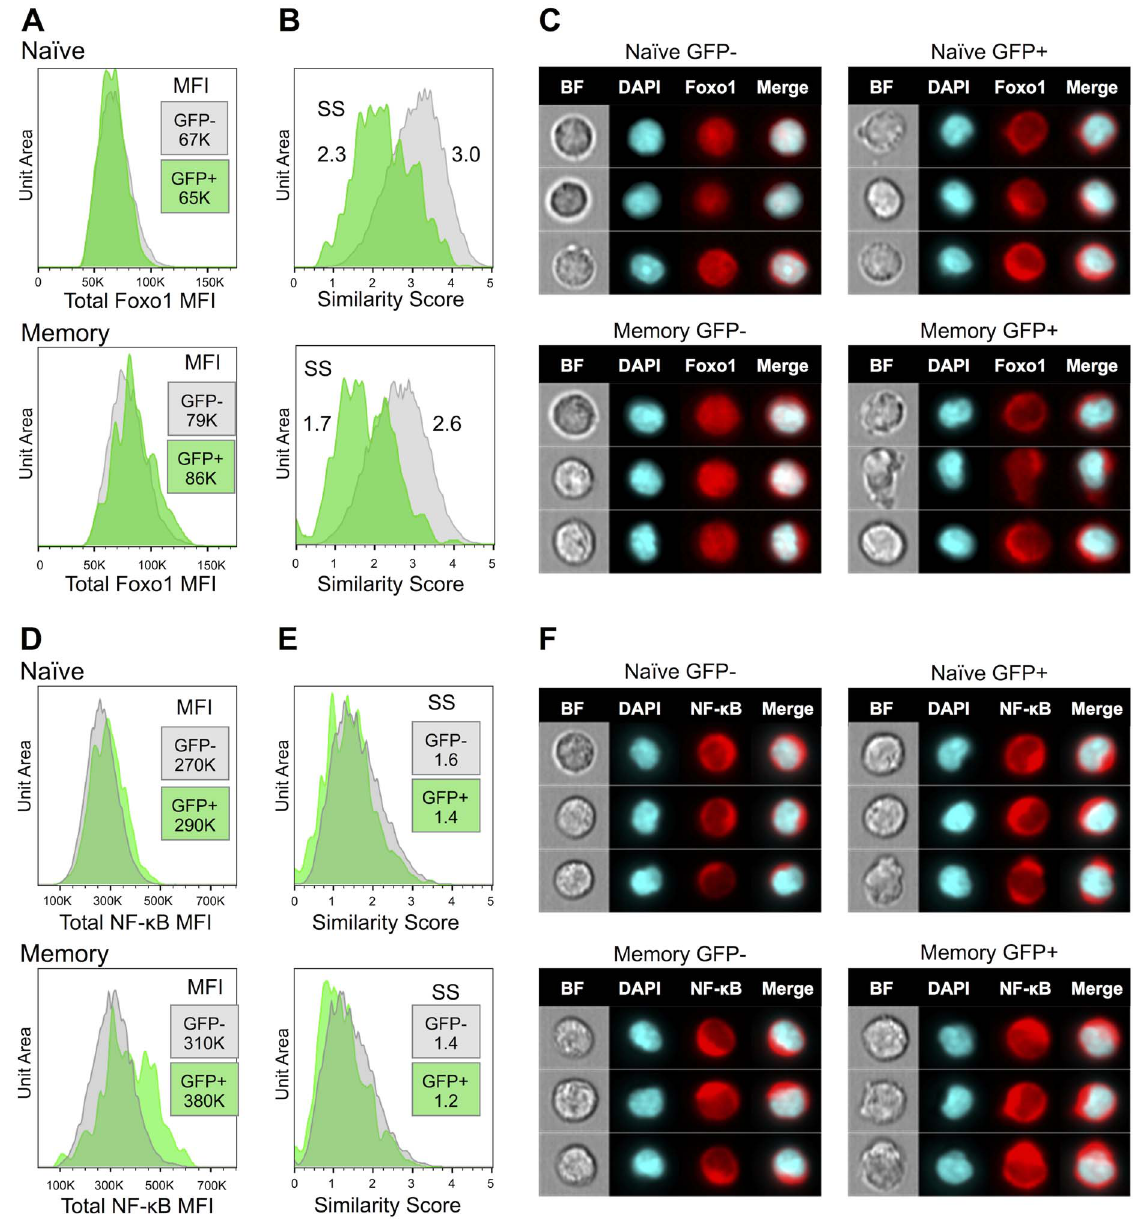
Figure 4. ImageStream analysis of Foxo1 and NF- k B in HIV-1 infected cells. HIV-1 GFP-reporter virus-infected resting CD4 + T cells were stained for CD45RA, intracellular Foxo1 or NF- k B and for DNA (DAPI) 7 days after infection, then analyzed by ImageStream. One representative experiment of two is shown. A. Total Foxo1 expression in naı¨ve and memory GFP + and GFP- cells. MFI=Mean Fluorescence Intensity. B. Nuclear localization was analyzed in IDEAS software by comparison of Foxo1 distribution to nuclear DAPI staining using the Similarity Score (see materials and methods). C. Representative ImageStream pictures of individual cells stained for Foxo1. D. Total NF- k B expression in naı¨ve and memory GFP + and GFP- cells. E. NF- k B nuclear Similarity Scores. F. Representative ImageStream pictures of individual cells stained for NF- k